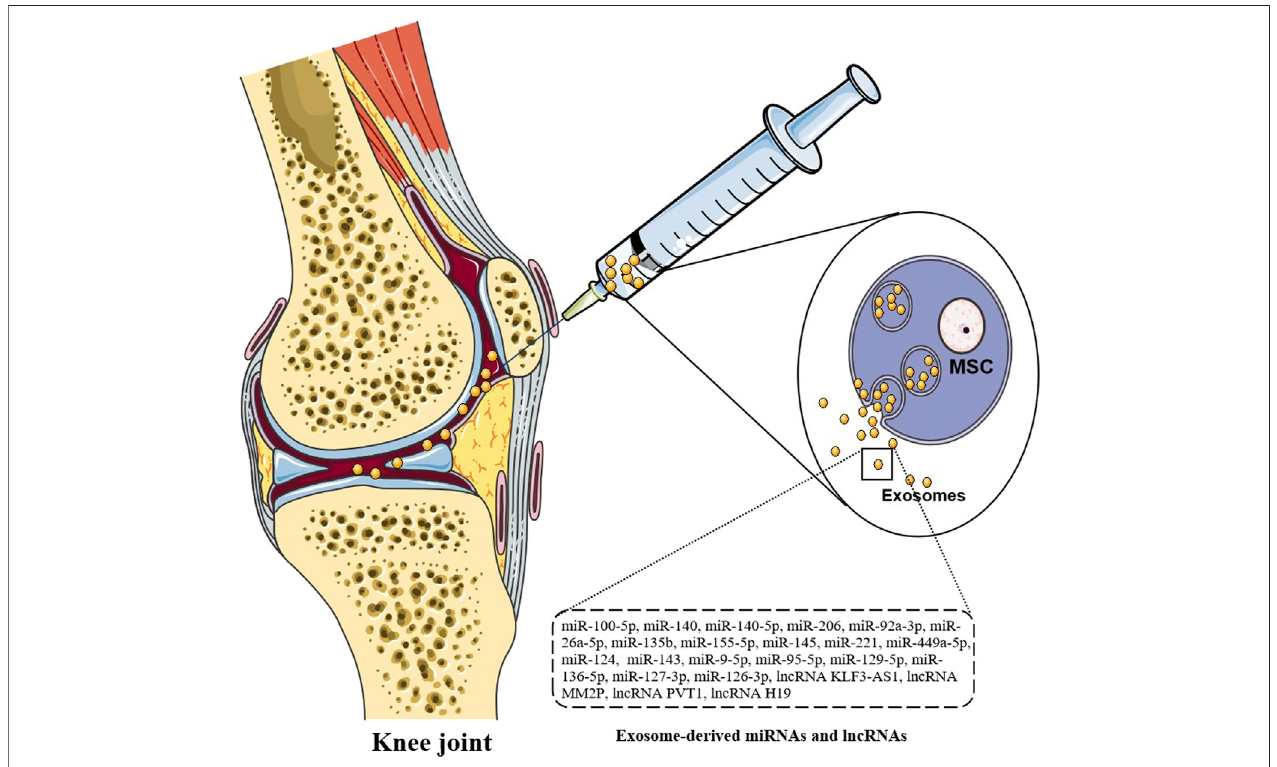
FIGURE 2 | Injection therapy of exosomes. Direct injection of exosomes carrying miRNAs and lncRNAs can signi fi cantly down-regulate arthritis score, inhibit FLS proliferation and invasion, and reduce in fl ammatory response and joint damage.